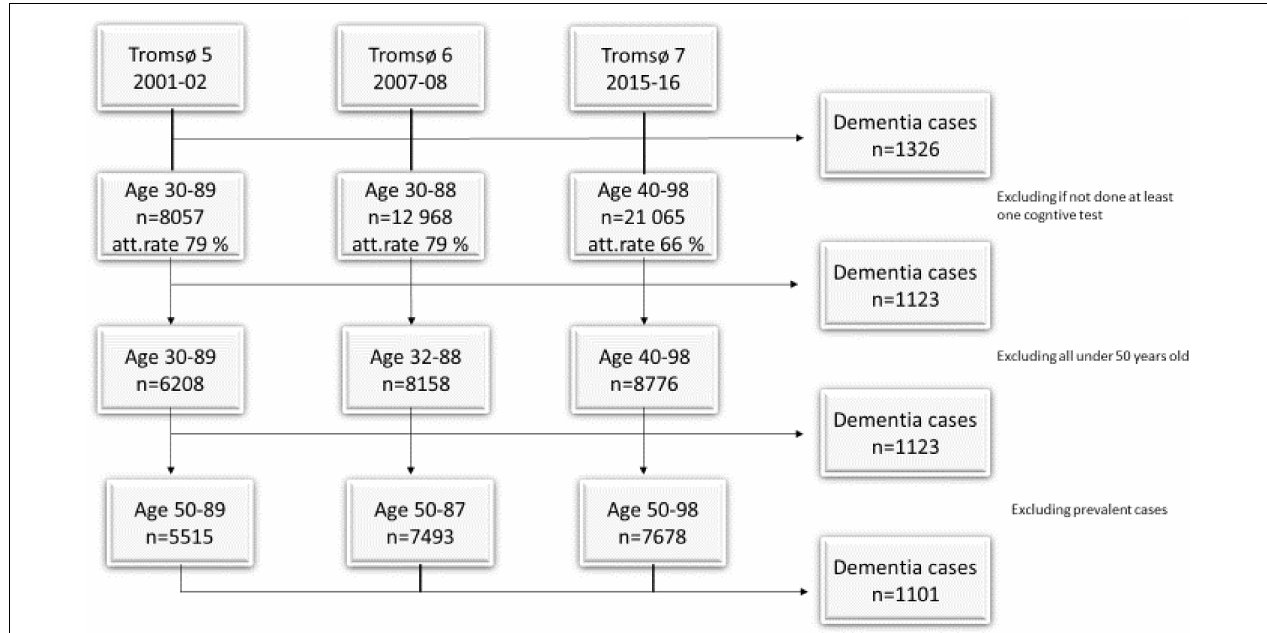
FIGURE 1 | The Tromsø Study 5–7, with survey year, age in years, attendance rate (att. rate), and number of cases (n).